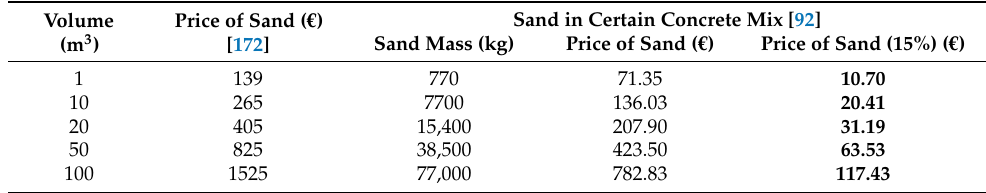
Table 2. Sand prices for application in concrete.